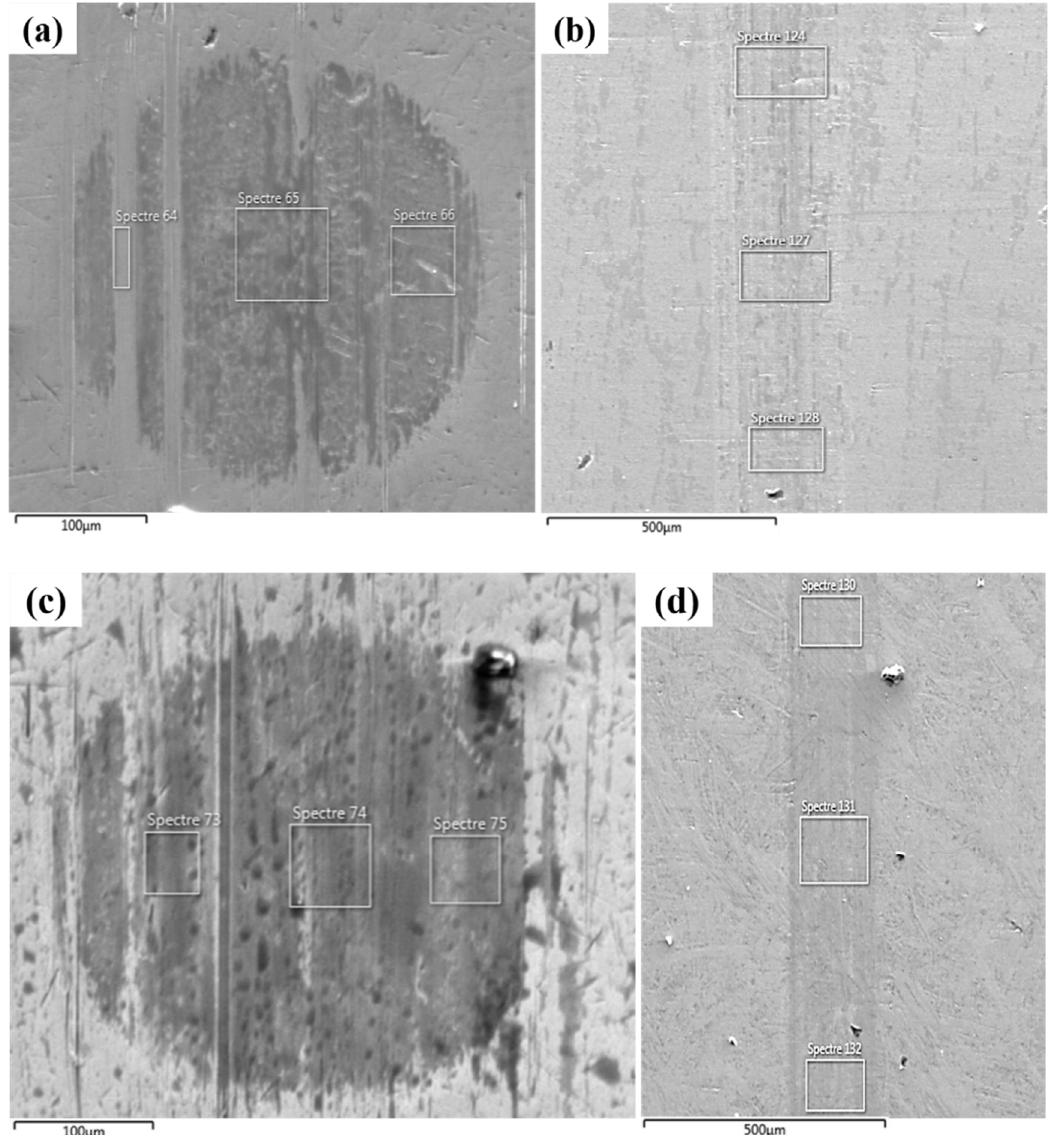
Figure 6. SEM images depicting the wear scar corresponding to: ( a ) the ball and ( b ) the block tested with the reference 5W-40 engine oil and ( c ) the ball and ( d ) the block tested with the rGO6 sample. The white square frameworks correspond to the regions of the samples where EDS analysis was conducted. EDS spectra are provided as Supplementary Materials in Figure S5. Table 3. An overview of the elemental analysis of the wear scar of the rubbing parts by EDS.